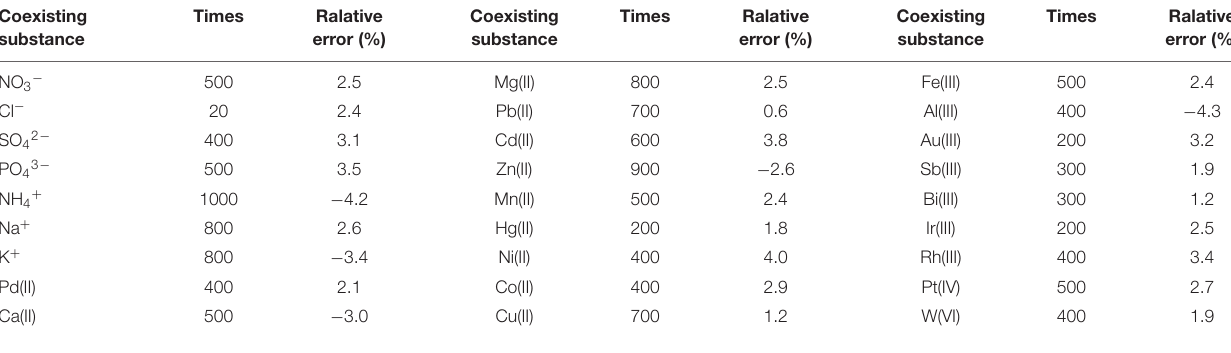
TABLE 3 | Effects of coexisting substances (c = 0.50 µ g/mL).